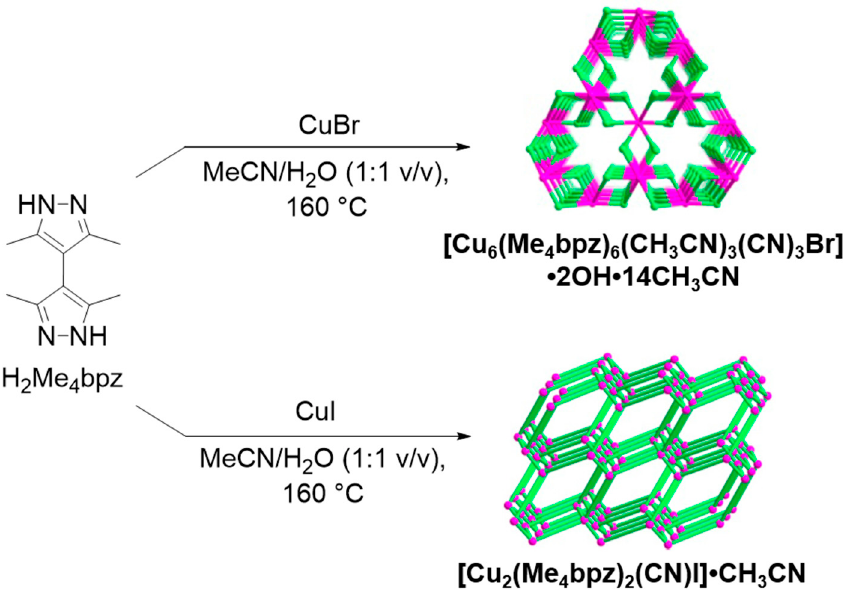
Figure 4. H 2 Me 4 bpz was reacted with Cu(I) halides to yield two Cu(I)-based metal–organic frameworks, which were shown to be effective catalysts for azide–alkyne click reactions. Adapted with permission from reference [65]. ©2015 ACS.